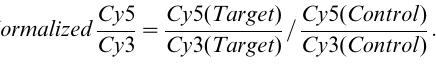
Figure S4 Antibody validation pipeline. All antibodies used for detection of NF k B-family proteins were validated by western blot to investigate if they could bind a protein of the estimated size, Co-IP to confirm that they could bind the native protein while interacting with its known interaction partners, and SP-PLA to find the best combination of binders to be used for PLA.